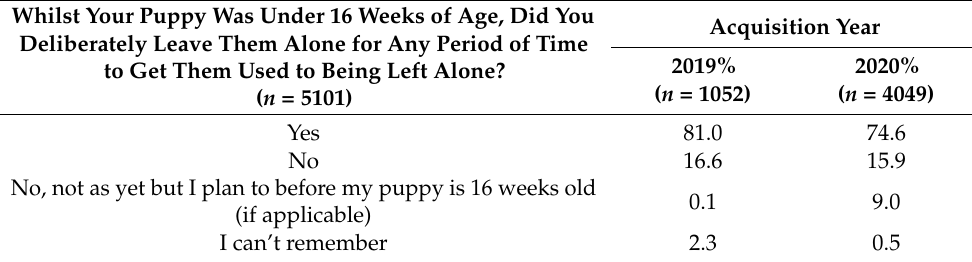
Table 8. Proportion of 2019 puppies ( n = 1052) and Pandemic Puppies ( n = 4049) deliberately left alone under the age of 16 weeks. The answer options listed represent all the choices available to